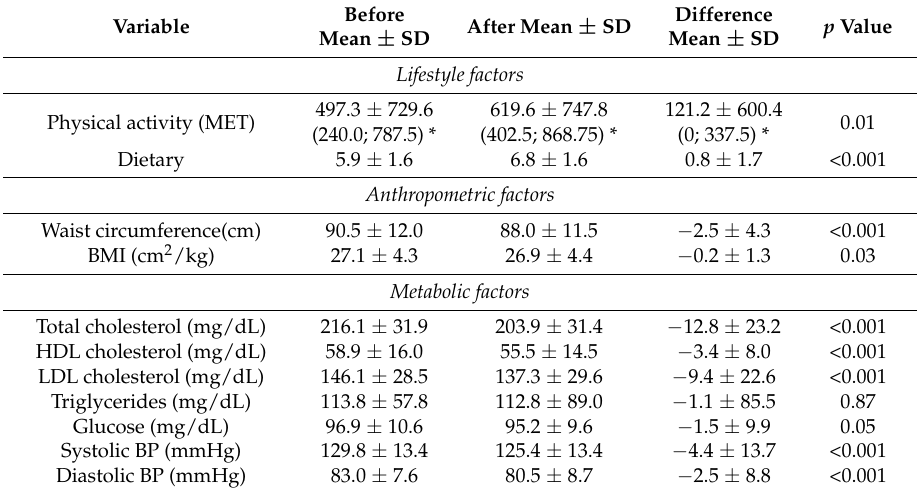
Table 2. Analysis on total sample before and after the intervention.